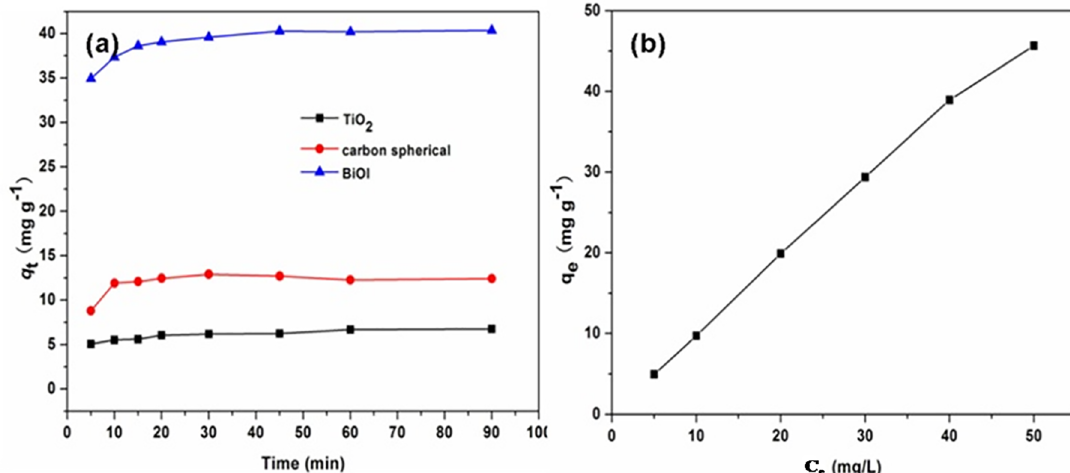
Figure 5. Time-dependent RhB concentration variation curve (a) and adsorption isotherms (b) over flower-like BiOI microspheres Table 1. Kinetic parameters for the adsorption of RhB onto BiOI sample